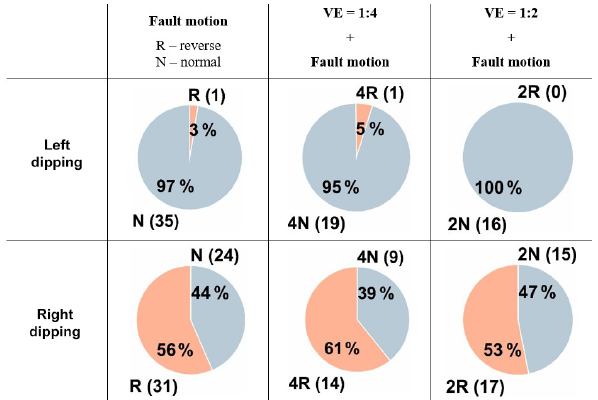
Figure 5. Statistics for the interpreted fault directions (left “L” or right “R”), and motions (normal “N” or reverse “R”), separated by vertical exaggeration (“VE”) 1 : 2 or 1 : 4.